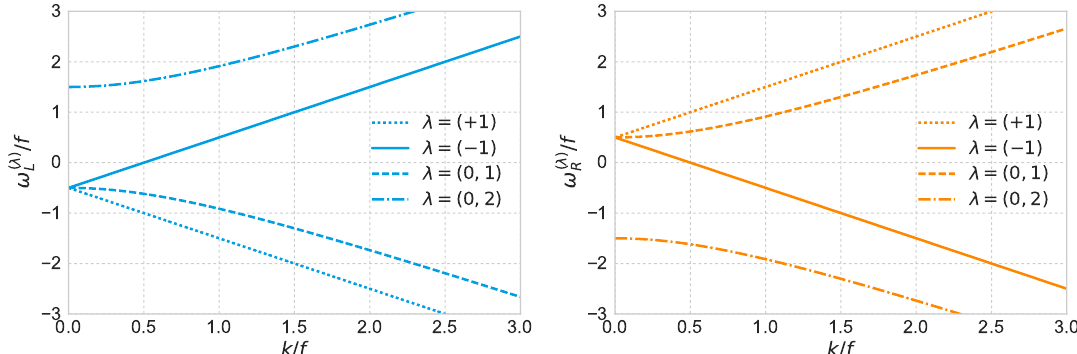
Figure 1 . Left panel : dispersion relation for the left-handed fermion. One mode, (cid:21) = ( (cid:0) 1), crosses the zero energy while the other three modes are gapped. Right panel : dispersion relation for the right-handed fermion. It is obtained from (cid:13)ipping the sign of the energy for the left-handed